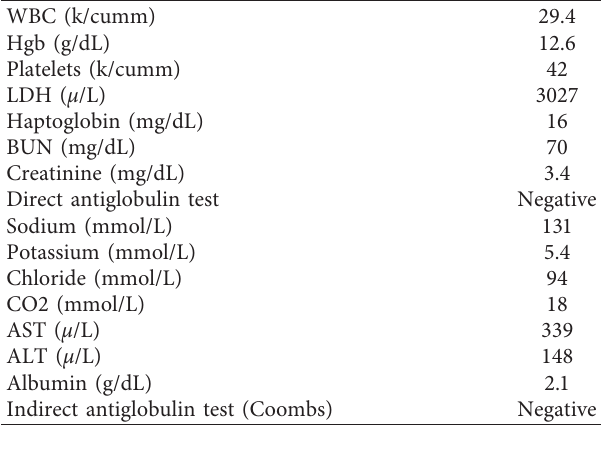
Table 1: Initial laboratory findings consistent with hemolytic uremic syndrome.